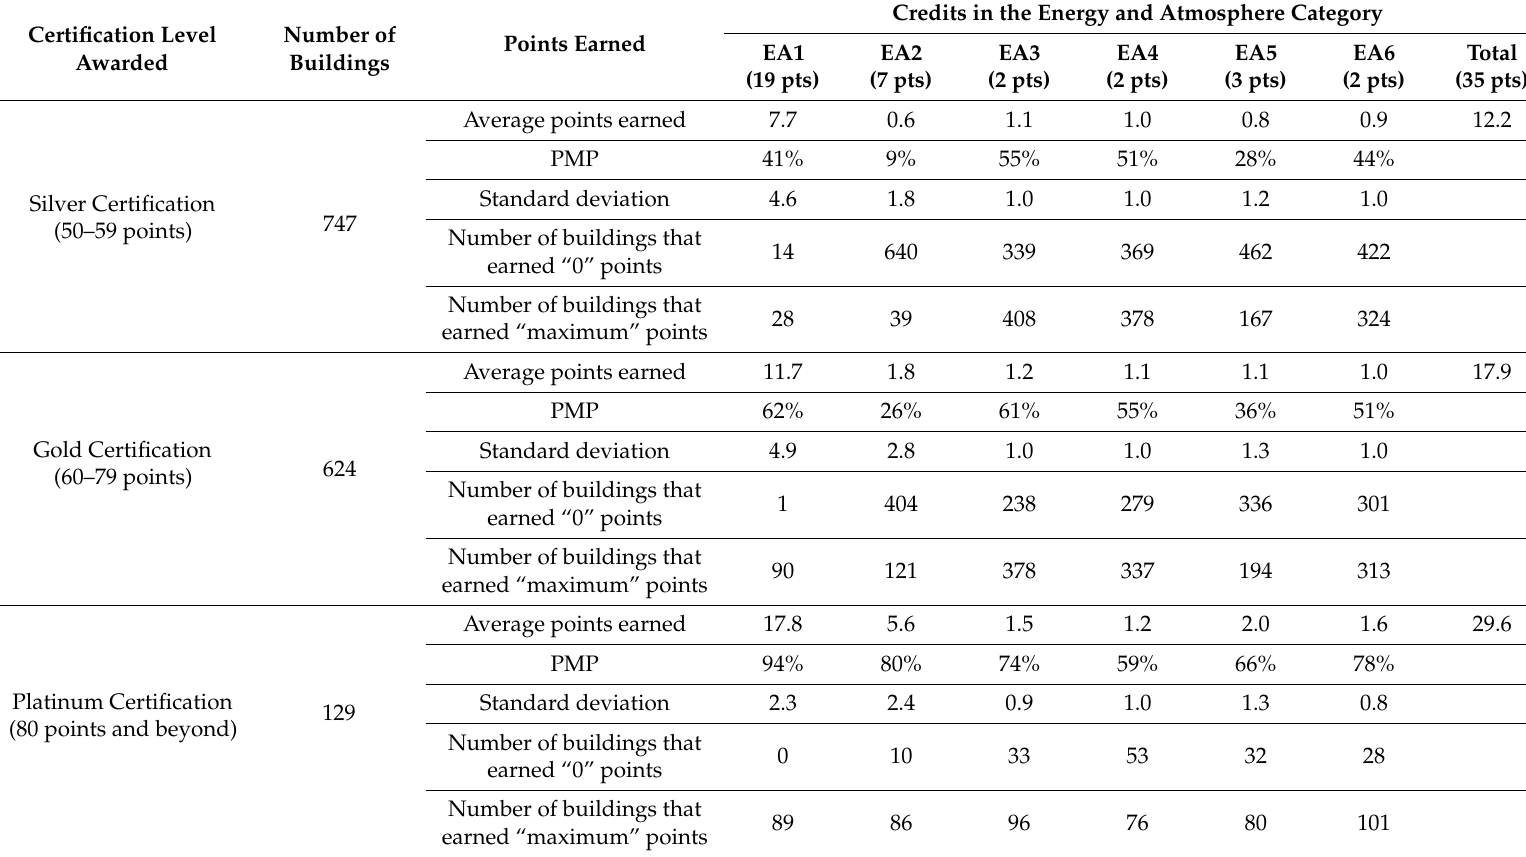
Table 4. Average points earned in the Energy and Atmosphere credits for new construction in the